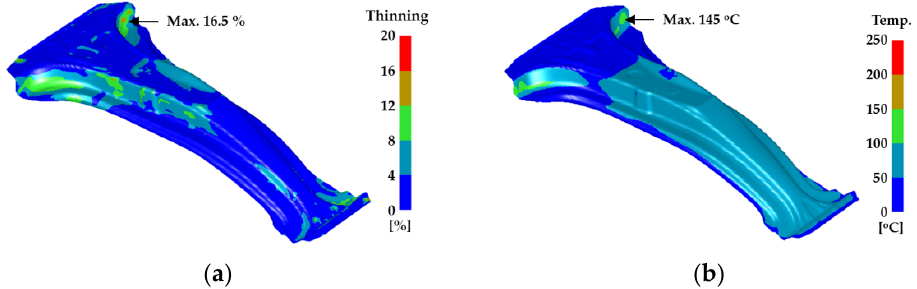
Figure 4. Results of FE simulation for hot stamping: ( a ) thinning distribution after forming stage and ( b ) temperature distribution after quenching stage.